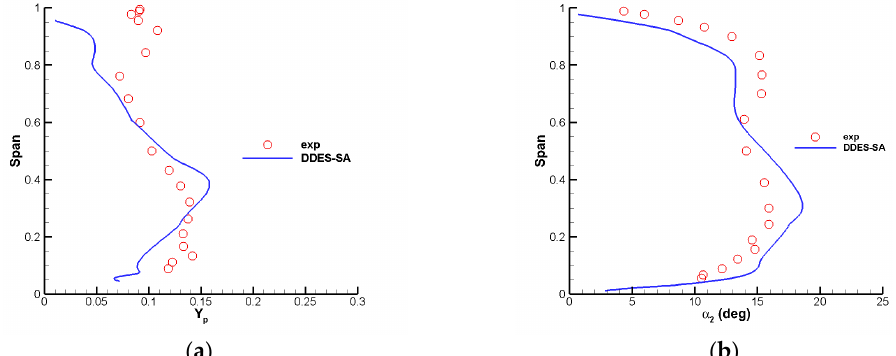
Figure 7. Loss coefficient ( Y p ) and exit flow angle ( α 2 ): ( a ) pitchwise mass-averaged loss coefficient; ( b ) pitchwise mass-averaged exit flow angle.